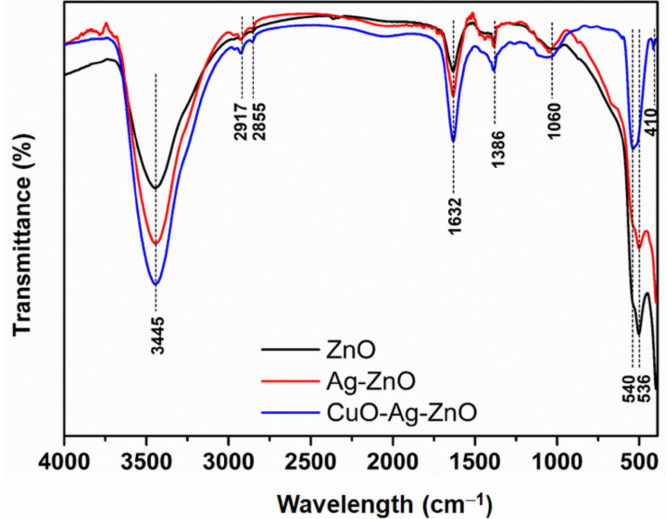
Figure 4. Fourier transform infrared (FTIR) spectra of